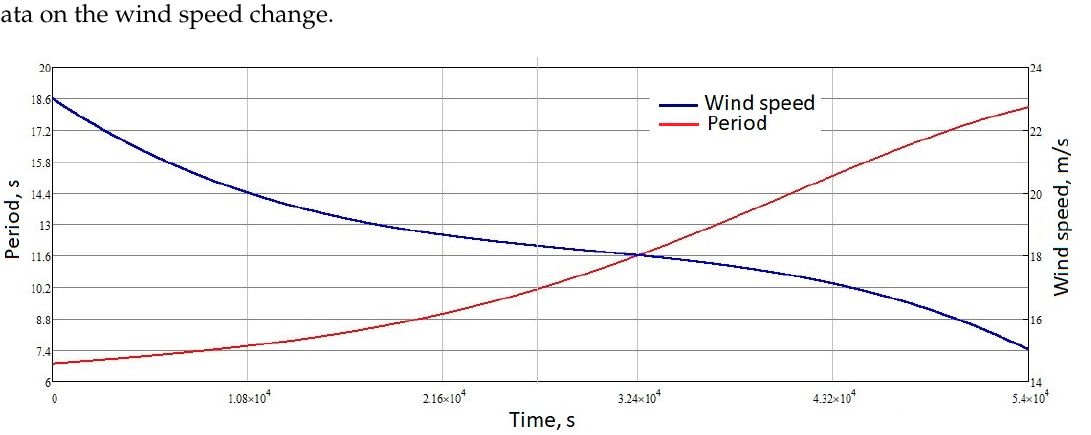
Figure 8. Graph of the swell period change on the typhoon speed and the angle of direction to the receiver (left scale, red curve), change in the typhoon wind speed (right scale, blue curve).